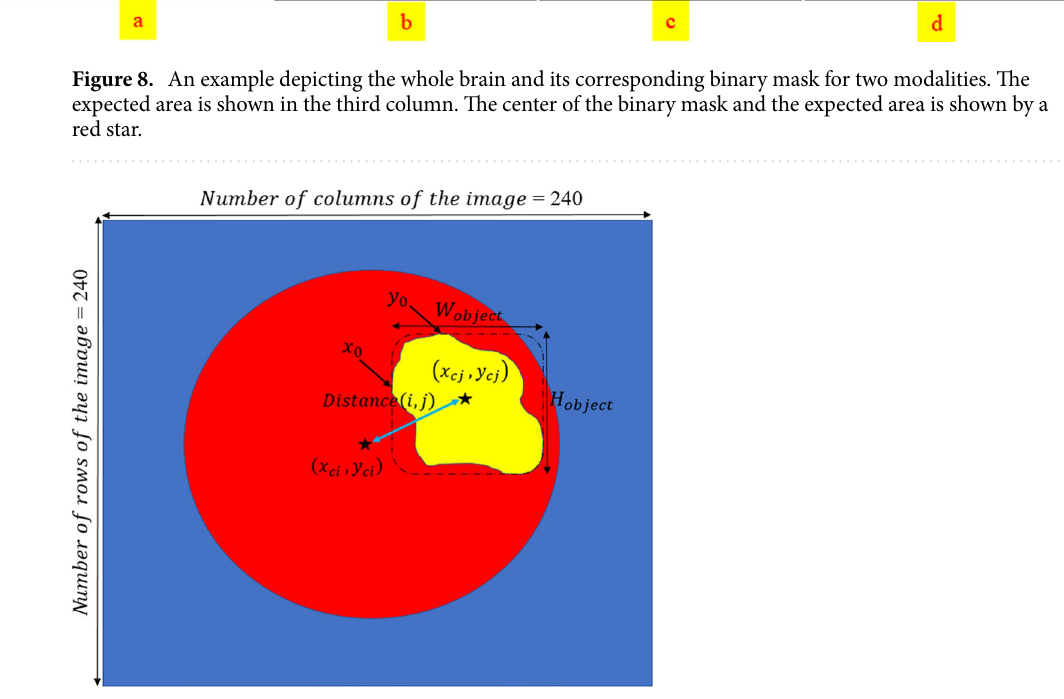
Figure 9. Illustration of parameter calculation in the Distance-Wise Attention (DAW) module. The blue and red pixels are the background and the brain, respectively. The expected area is represented by a yellow object. The size of the image is 240 ×